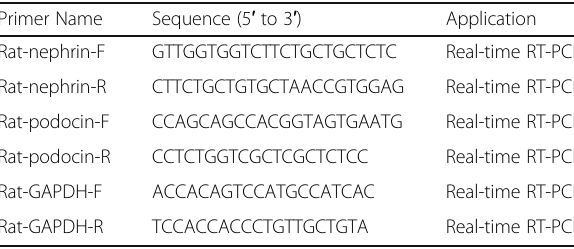
Table 1 Primers used for gene expression analyses. F, forward primer; R, reverse